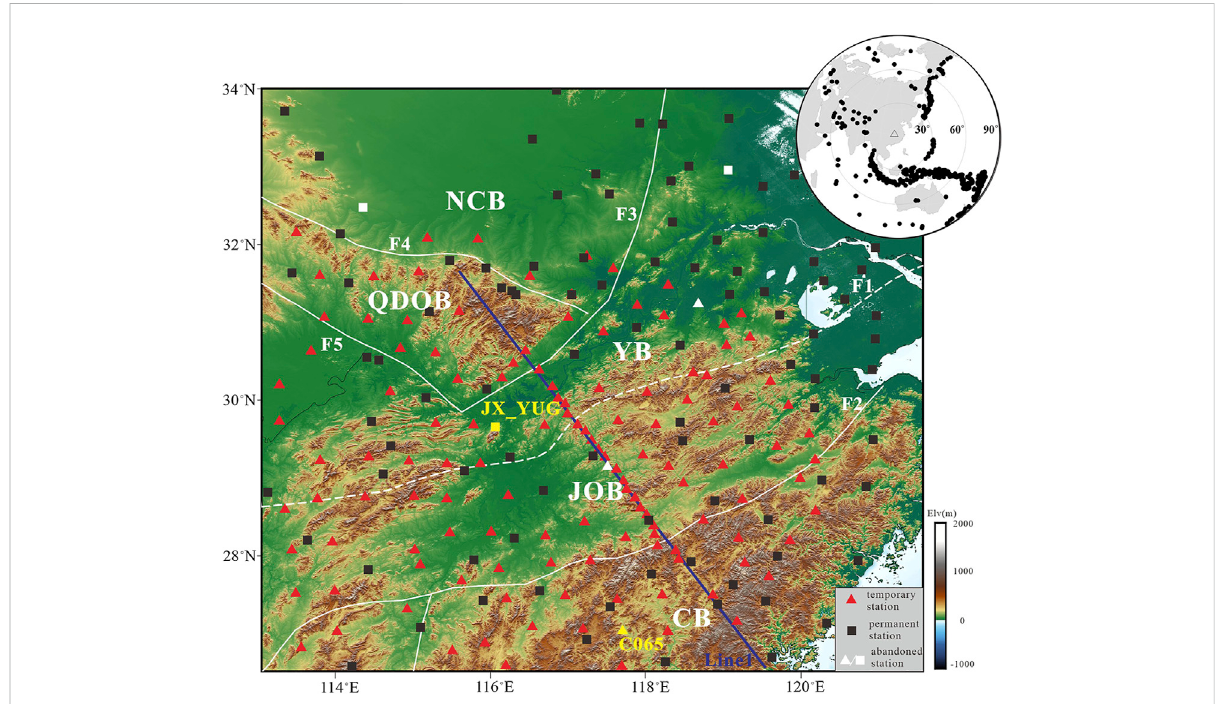
FIGURE 2 Location map of seismic stations and teleseismic events (upper right corner) in Southeastern China. The background color map indicate the topography. The yellow triangles and squares represent the locations of the stations shown in Figure 3 and Figure 4 respectively. Blue solid lines representCCPstackingsection(seeFigure9C,modi fi edfromYeetal.,2019).Thetriangleandblackdotsintheupperrightcornerindicatethecenter of the study area and teleseismic events, respectively. Main structural lines and fault lines are described in Shu et al.